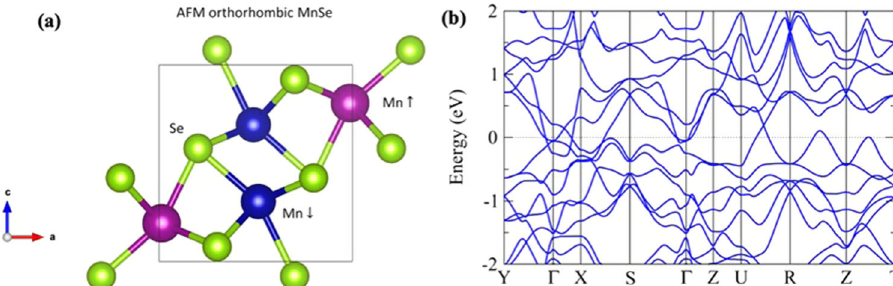
Fig. 5 The band structure calculation for orthorhombic MnSe. a The crystal structure of orthorhombic MnSe. Purple, blue, and green spheres represent Mn, Mn, and Se atoms, respectively. b The band structure of orthorhombic MnSe with a = 5.280 Å, b = 2.999 Å, and c = 5.472